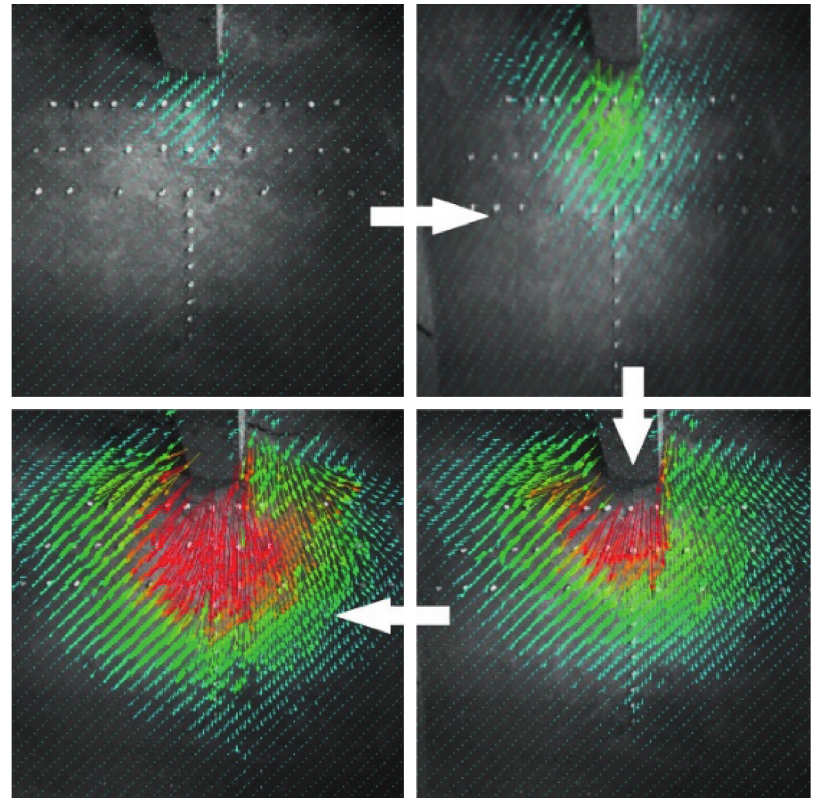
Figure 11: Vectorial displacement field under 45 ° slope.